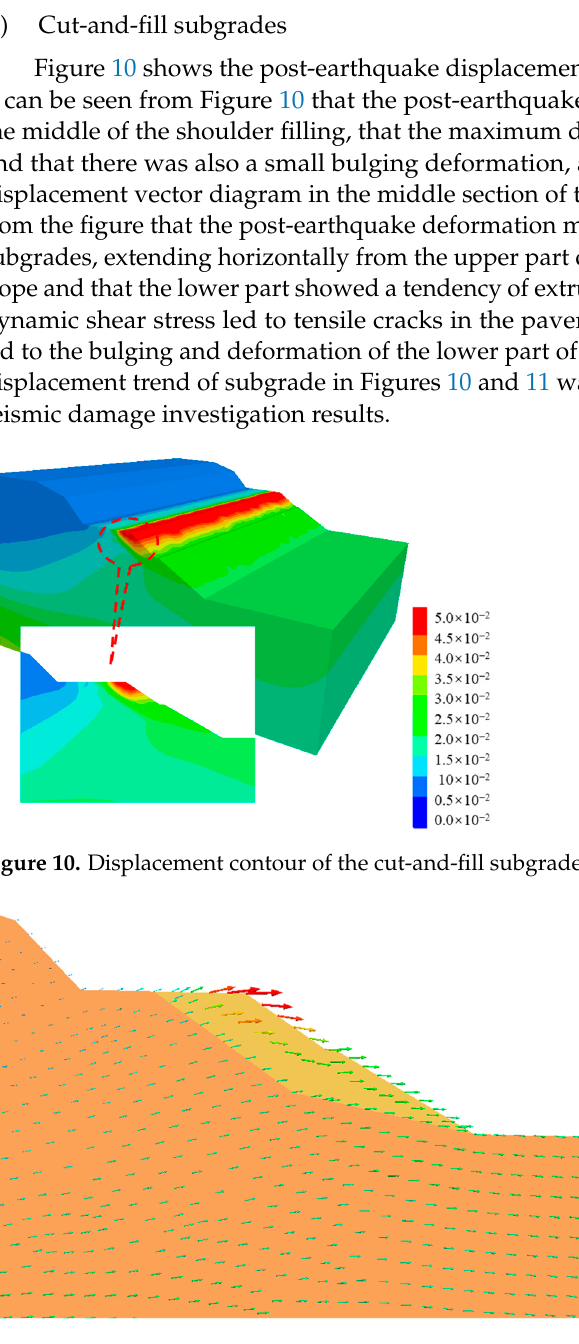
Figure 11. Displacement vectors of the cut-and-fill subgrade after earthquake.